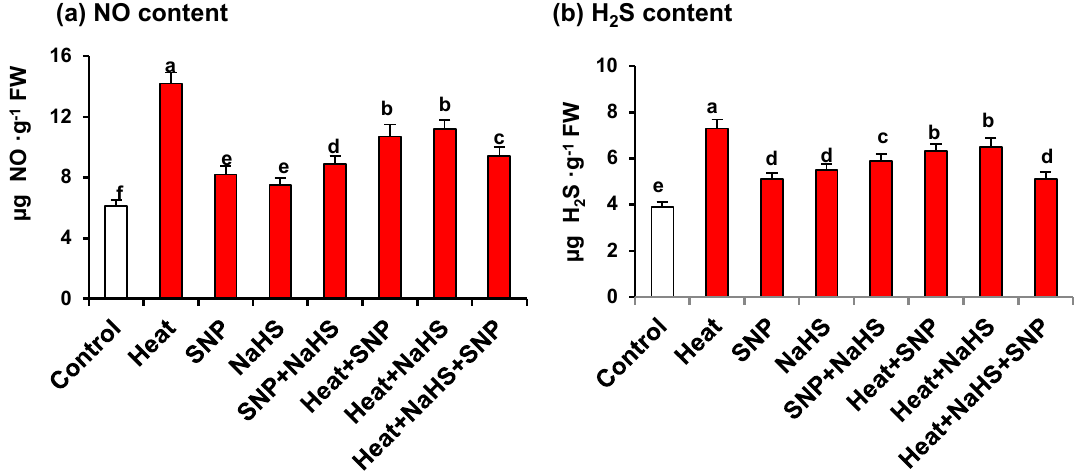
Figure 4. ( a ) Nitric oxide and ( b ) H 2 S content in wheat ( Triticum aestivum L. var. WH 542) leaves treated with SNP (100 µM) and/or NaHS (200 µM) in the presence (40 °C) or absence (25 °C) of heat stress at 30 days after sowing (DAS). Data are presented as treatments mean ± SE ( n = 4). Data followed by the same letter are not significantly different by LSD test at ( p < 0.05). SNP, sodium nitroprusside; H2S, sodium hydrosulfide. FW, fresh weight.